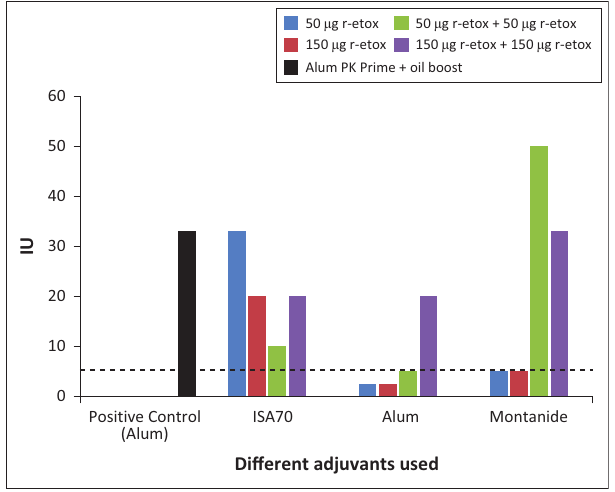
FIGURE 3: Efficacy of recombinant toxoid vaccine candidates using serum of vaccinated guinea